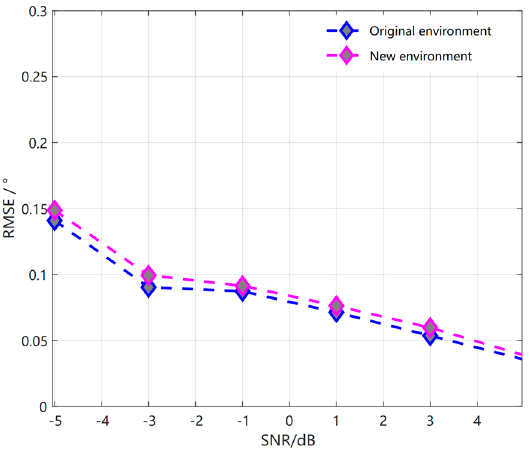
Figure 13. Comparison of RMSE of S2S network meta − reinforcement learning algorithm based on the original environment and the new environment.